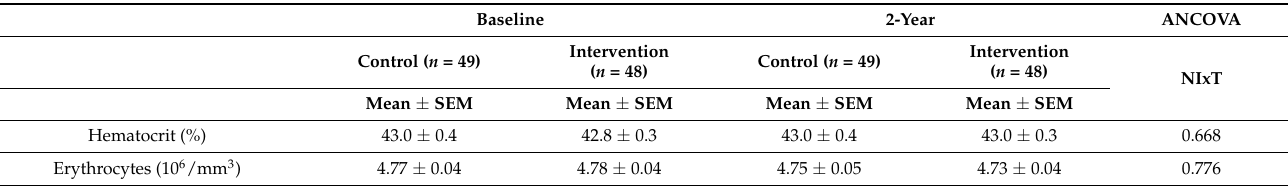
Table 2. Hemogram of participants according to nutritional and lifestyle intervention between baseline and 2-years follow